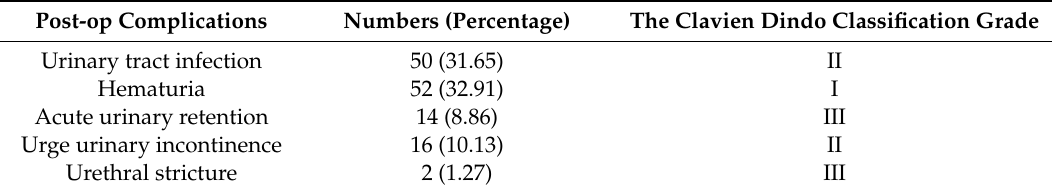
Table 6. Post-operative (post-op)